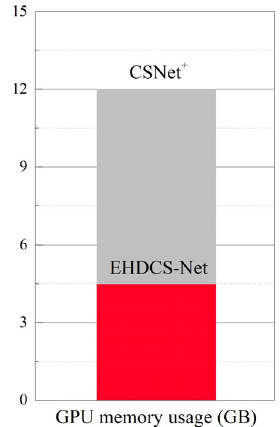
Figure 8. Comparison of GPU memory usage between CSNet + and EHDCS-Net in the case of CS ratio = 0.1. Figure 9. Comparison of GFLOPs among EHDCS-Net, EHDCS-Net without downsampling, and CSNet + in the case of CS ratio = 0.1.